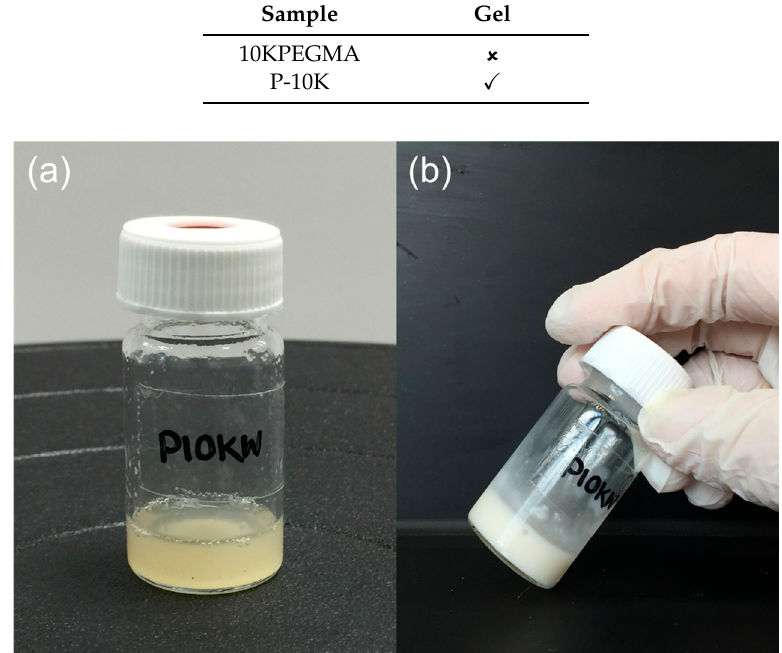
Figure 12. Pectin-PEGMA solution turned white after the addition of α -CD: ( a ) original 10% P-10K solution; and ( b ) 10% P-10K solution after the addition of α -CD (10%).